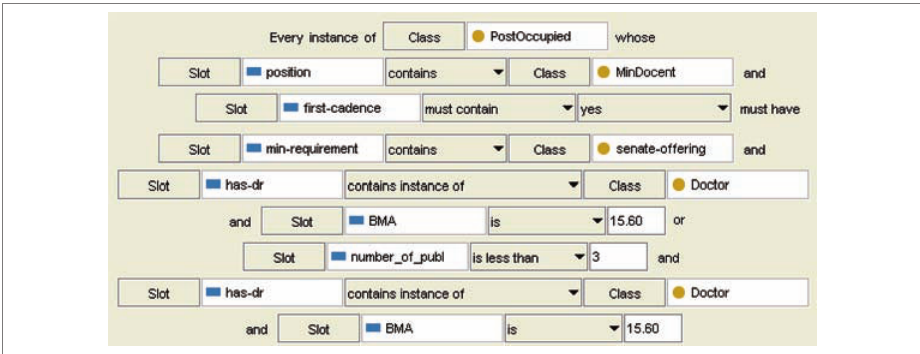
Fig. 5 . The fifth axiom defined using EZPAL Tab plug-in